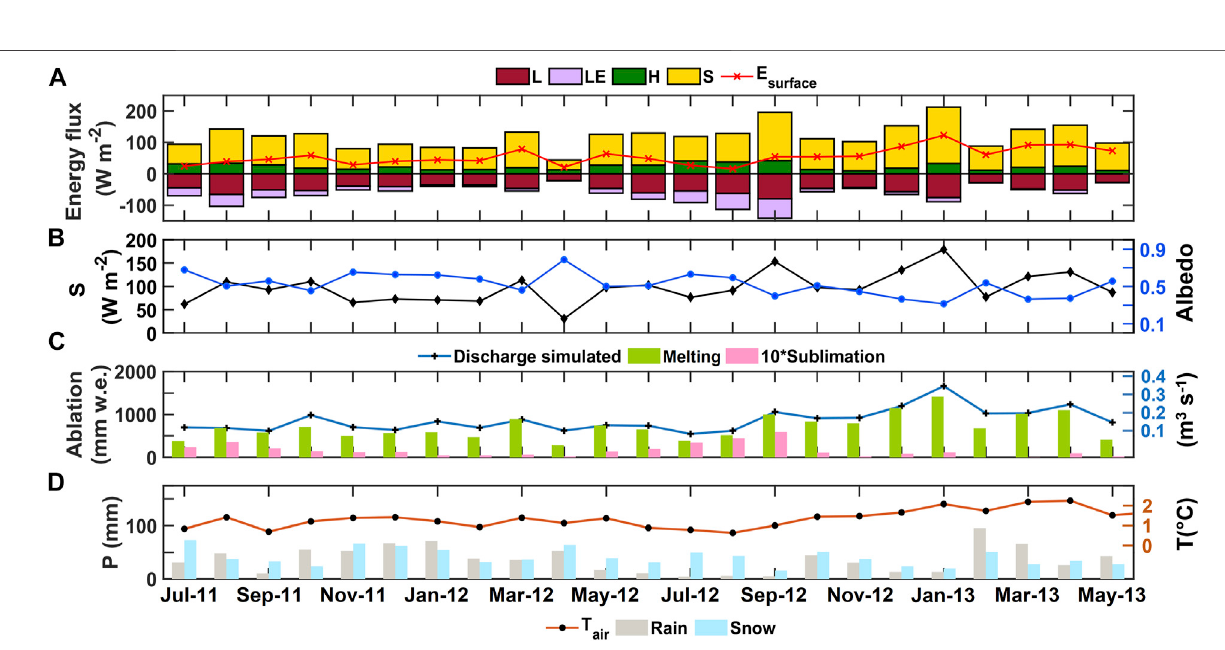
FIGURE 9 | (A) Monthly values of the surface energy balance components and resulting energy available at surface (red line) for the 4,780 m a.s.l. band nearest to SAMA-1. (B) Comparison between net short-wave radiation (black line) and albedo (blue line) at 4,780 m a.s.l. (C) Monthly discharge simulated (blue line), accumulated melting (green bars) and sublimation (pink bars) at 4,780 m a.s.l. For visualization purposes, sublimation was multiplied by a 10 factor. (D) Monthly air temperature measured in SAMA-1 (brown line) and accumulated snow and rain measured in P8. Separation phase was determined through PSO